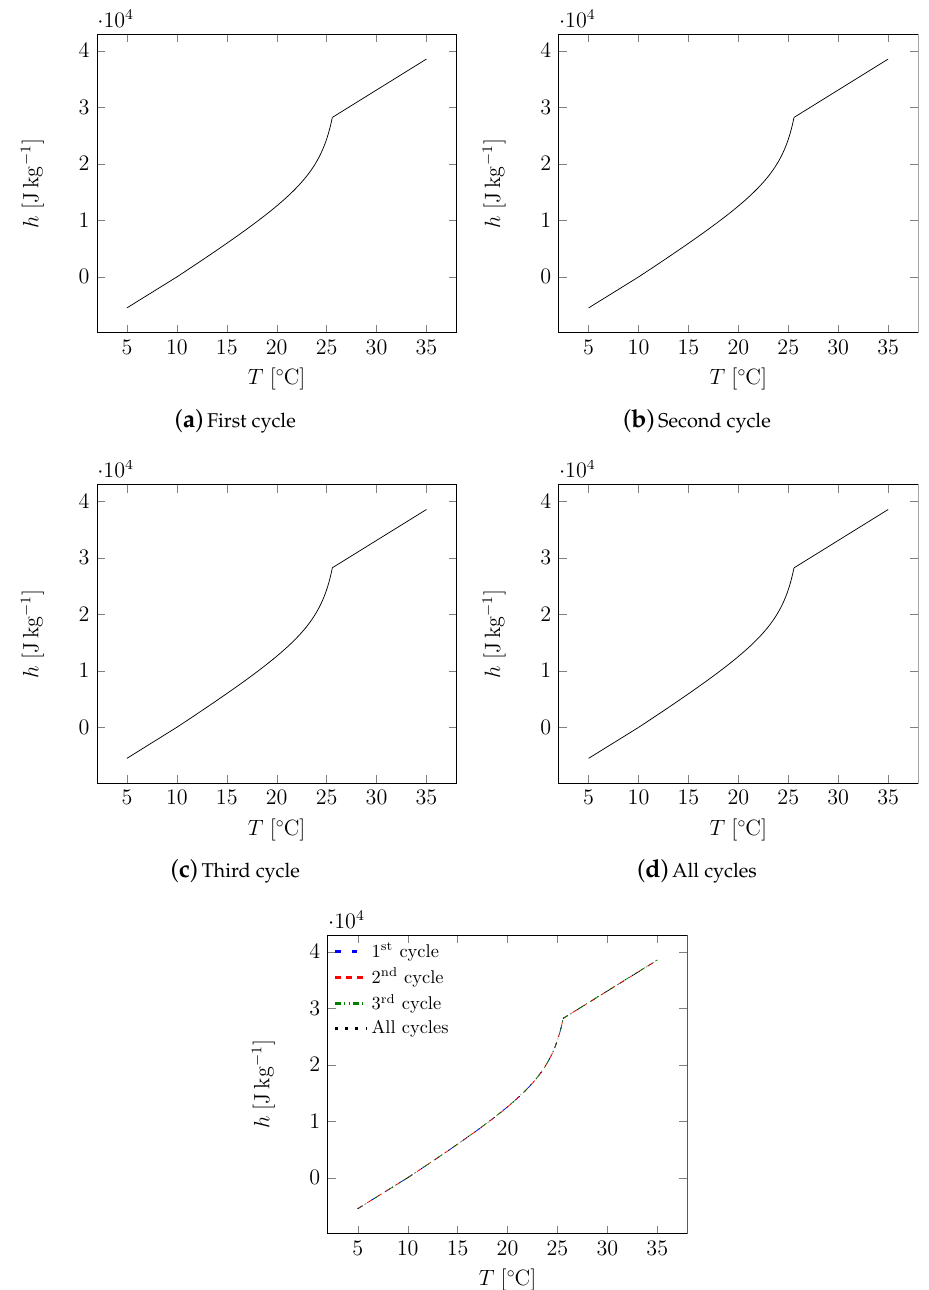
Figure 8. 12.4% w -PCM mortar: comparisons of the identified enthalpy functions for 2h heating/cooling ramp ( n.b. unique formulation pertaining for both fusion and